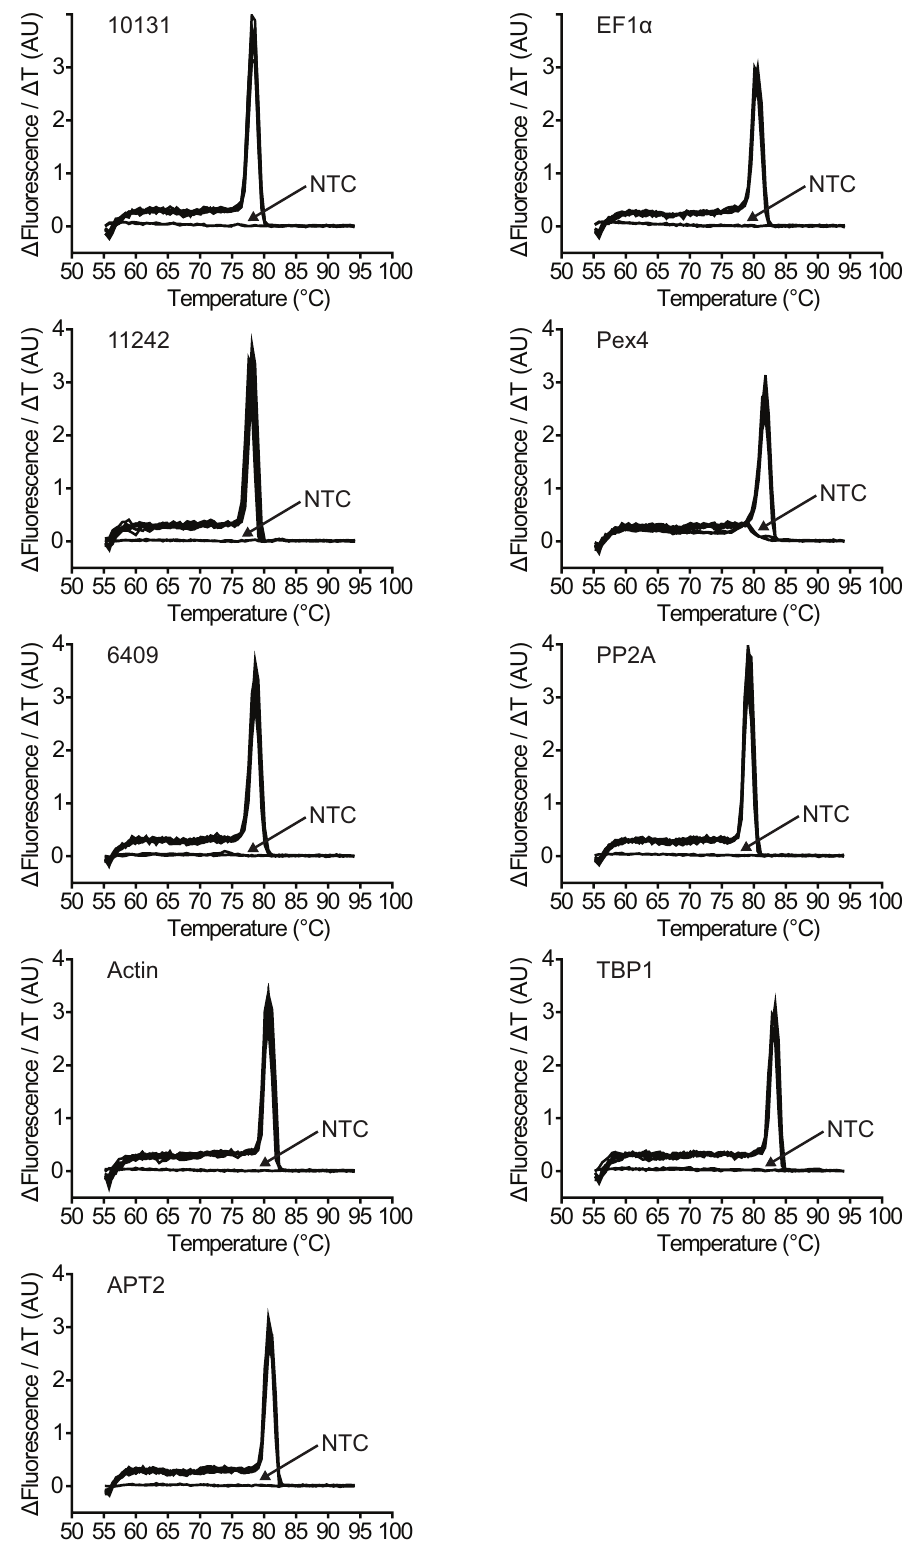
Supplementary Figure 2. Melting curve analysis of RT-PCR products . NTC indicates: no template